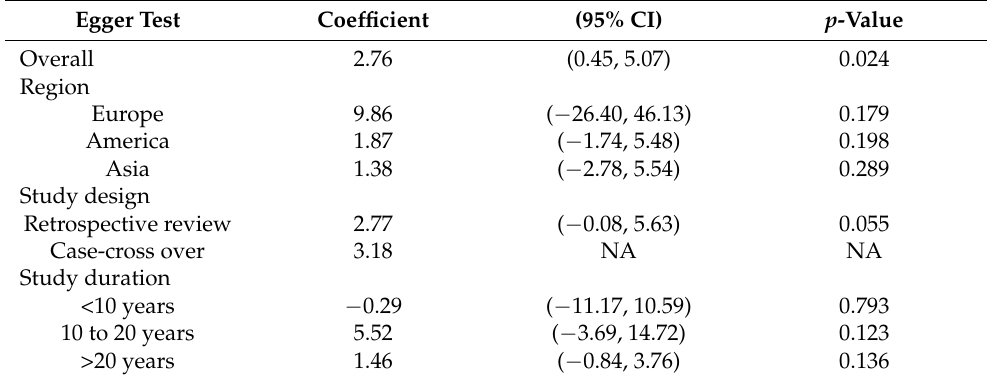
Figure 6. Funnel plot for the pooled proportion of AVM hemorrhage per pregnancy [9,10,12,20–28]. Table 5. Egger’s test of the study.